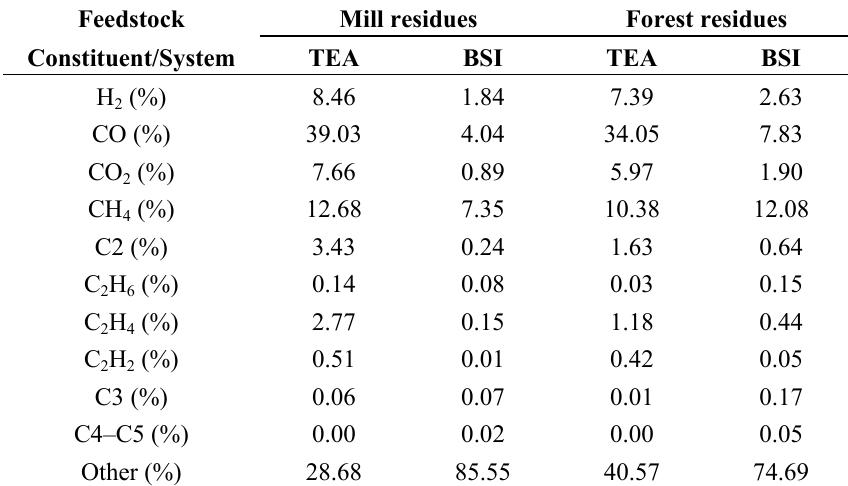
Table 2. Producer gas chemical composition.